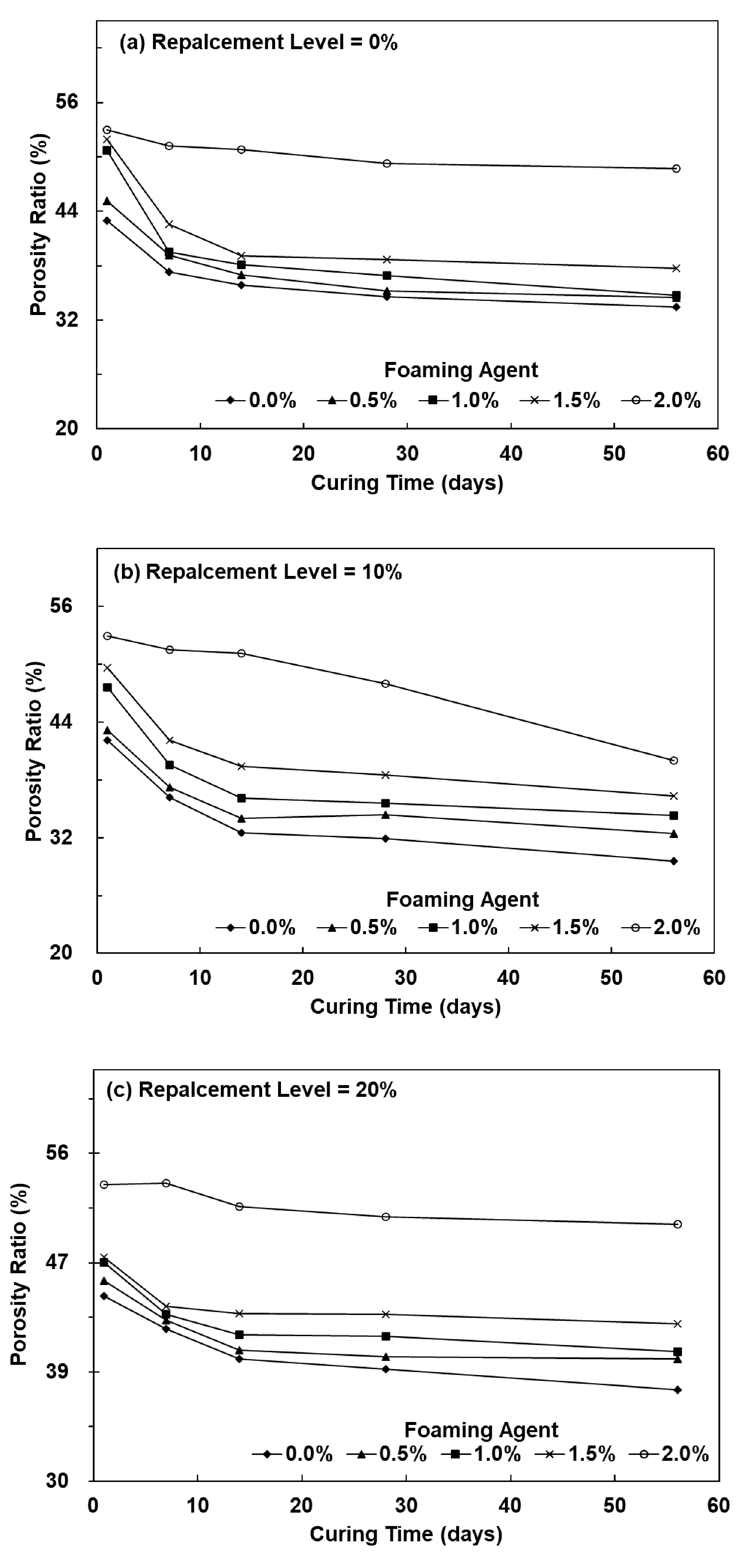
Figure 2. The porosity ratio of lightweight FGPs with SCS replacement levels. ( a ) 0%; ( b ) 10% and ( c )